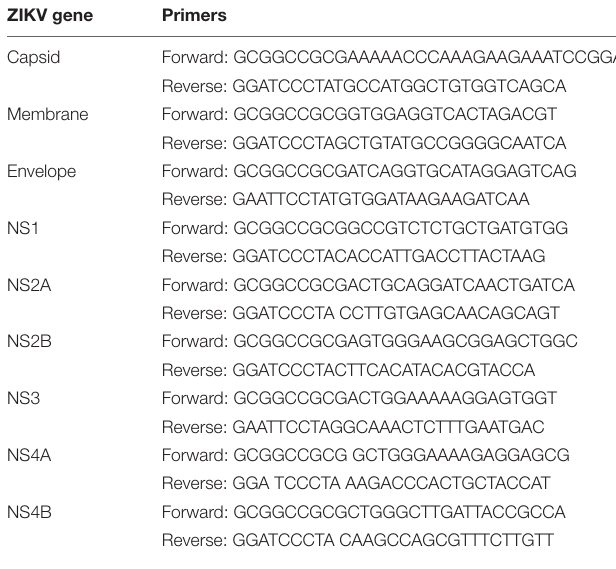
TABLE 1 | The ZIKV FS13025 (Cambodia, 2010, GenBank Accession: JN860885.1) gene